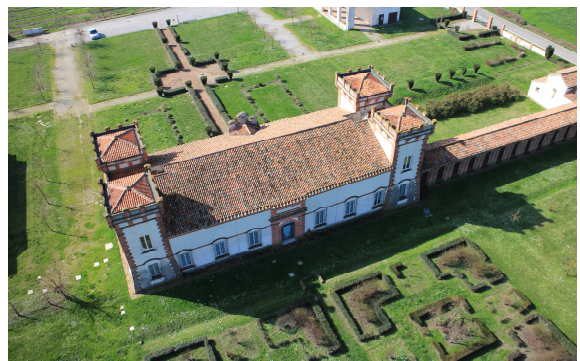
Figure 1. The test site: the “Delizia del Verginese” Castle (XV